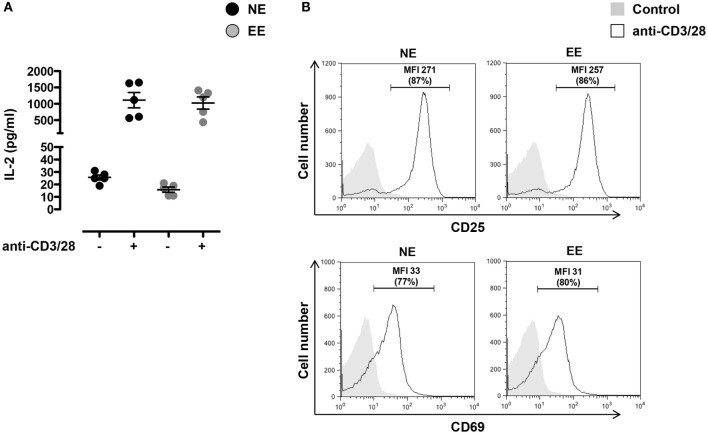
Effect of 2 weeks EE on T cell activation in vitro. (A) Levels of IL-2 in the cell supernatants of NE and EE T cells isolated from lymph nodes stimulated with 0.5 μg/ml of plate-bound anti-CD3/CD28 for 24 h. Data shown means ± SEM from n = 5 mice and representative of n = 3 separate experiments with similar results. (B) NE and EE T cells were left untouched (shaded histogram) or stimulated with 0.5 μg/ml of plate-bound anti-CD3/CD28 (white histograms) for 16 h and then stained for the activation markers CD25 or CD69. The numbers in the plots show the mean fluorescence intensity (MFI) and percentage of gated cells (in brackets) of the anti-CD3/CD28 activated T cells. Data shown are from n = 5 mice and representative of n = 3 separate experiments with similar results.